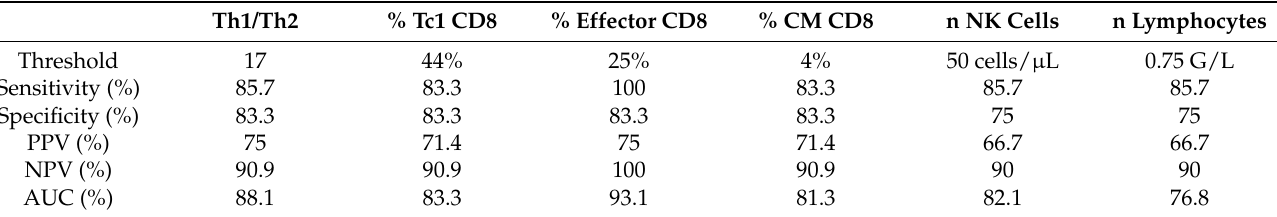
Table 4. Results of ROC curve analysis.